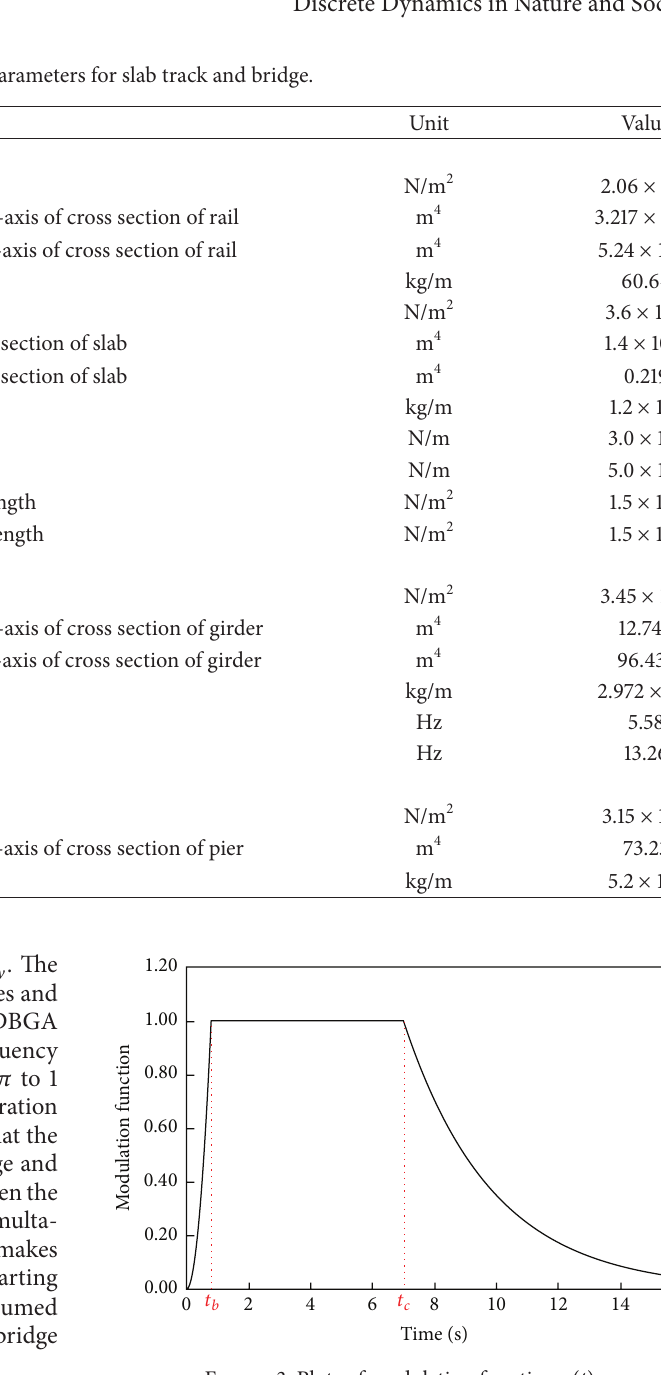
Figure 3: Plots of modulation function g (𝑡)